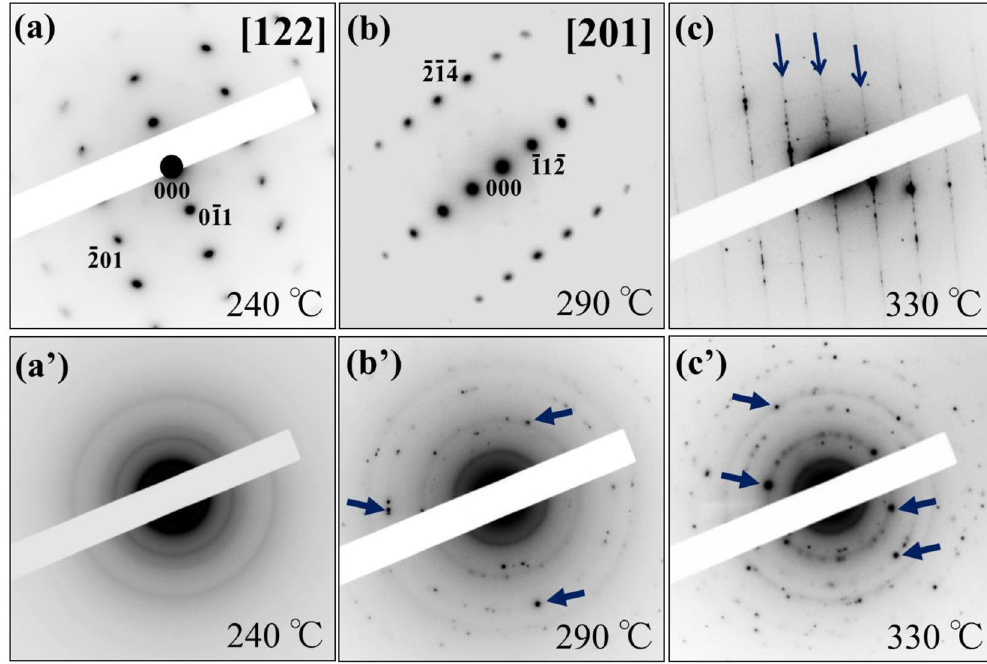
Figure 5. The heat temperature dependence of the ED patterns in the charged NMC composites with the 1 M LiPF 6 -EC/EMC solution. The ED patterns of NMC are shown in ( a – c ), while the ED patterns of LiPF 6 are shown in ( a’ ), ( b’ ) and ( c’